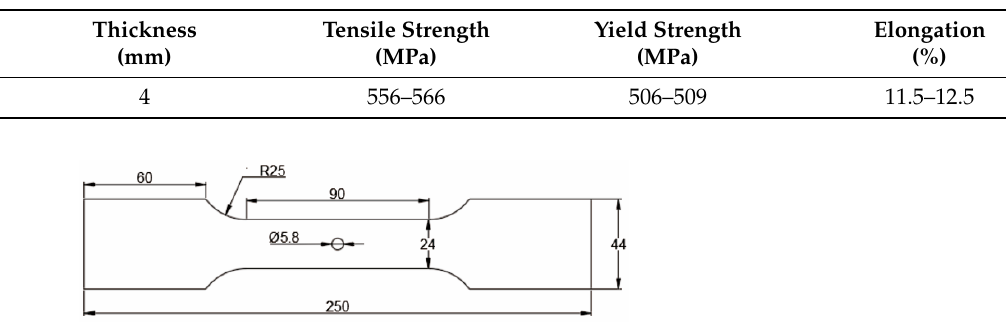
Table 2. 7075-T6 Plate Thickness and Mechanical Properties.